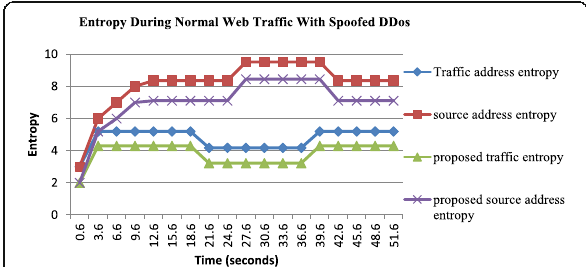
Fig. 7 Entropy during normal web traffic with Spoofed DDoS attacks the source address and traffic address entropy are observed and